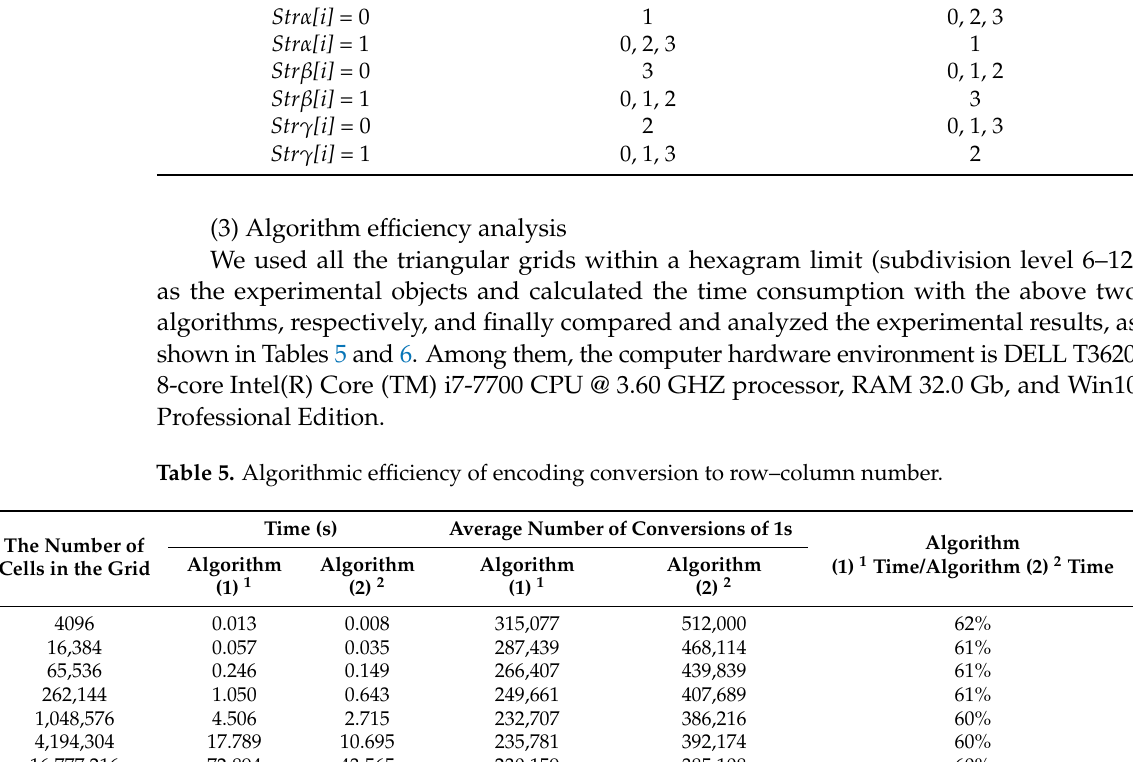
1 Row–column algorithm. 2 Three-orientation translating algorithm. Table 6. Algorithmic efficiency of row–column number conversion to encoding.